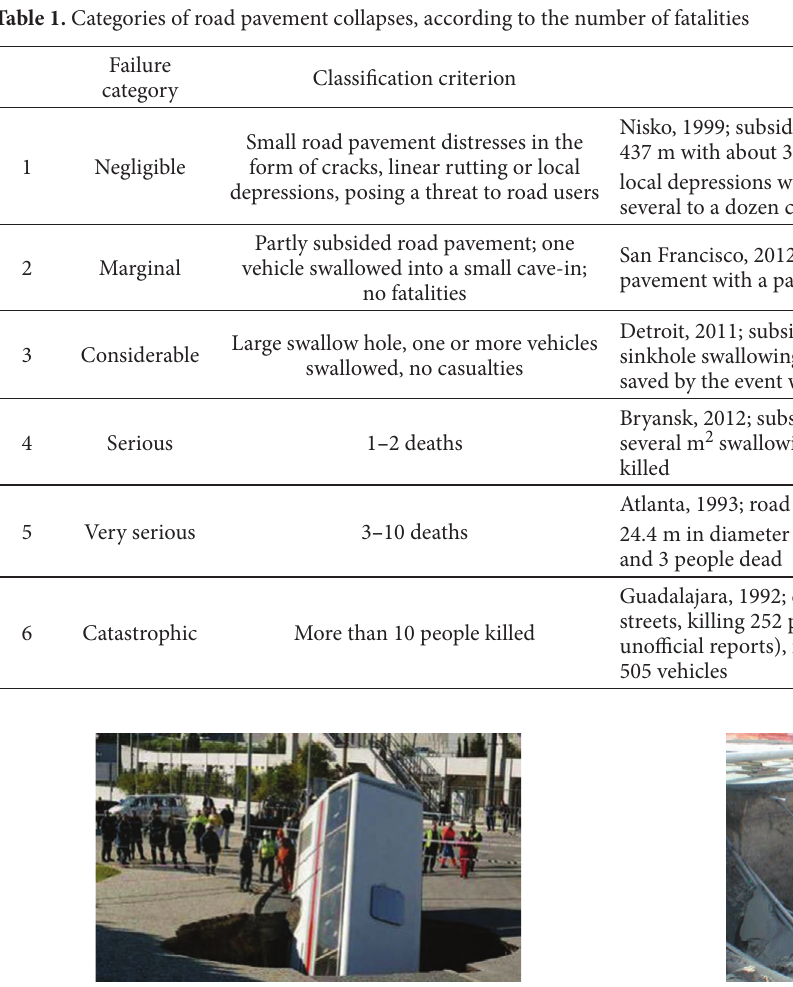
Fig. 1. Road pavement collapse with a swallowed bus Fig. 2 . Road pavement collapse with visible damaged cables and